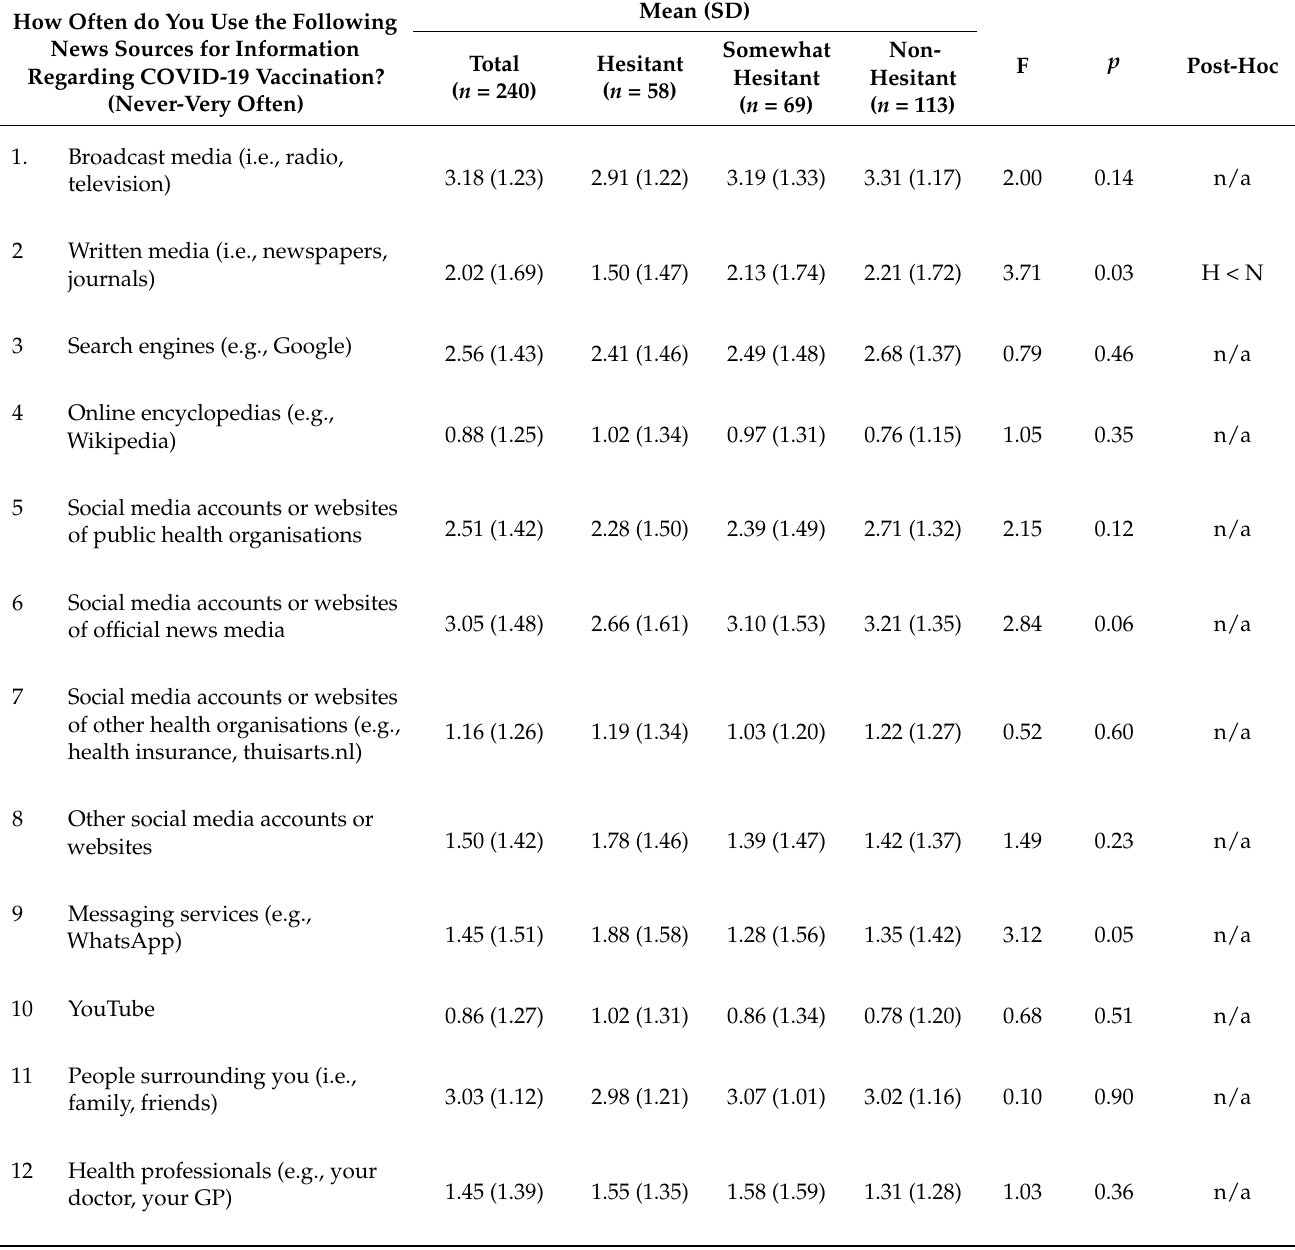
Table 2. Between-Group Variance Analyses for Information Seeking